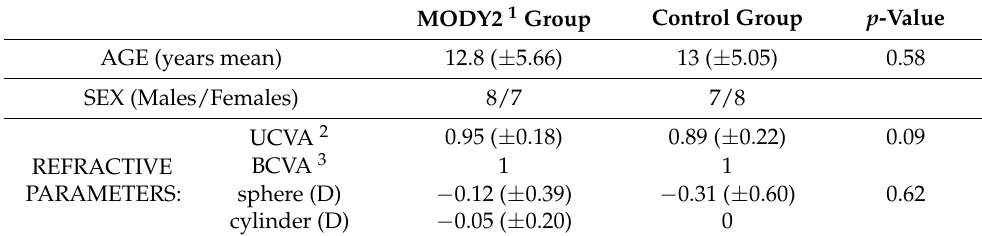
Table 1. Age, sex, and refractive characteristics of the overall study